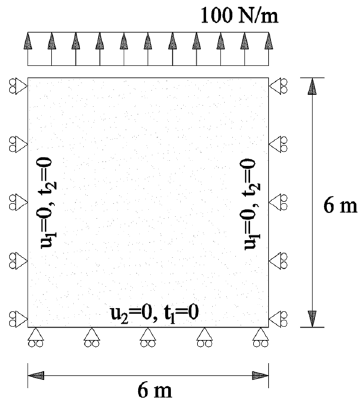
Figure 5. The considered plane strain boundary condition for validation of the dynamic lattice model.